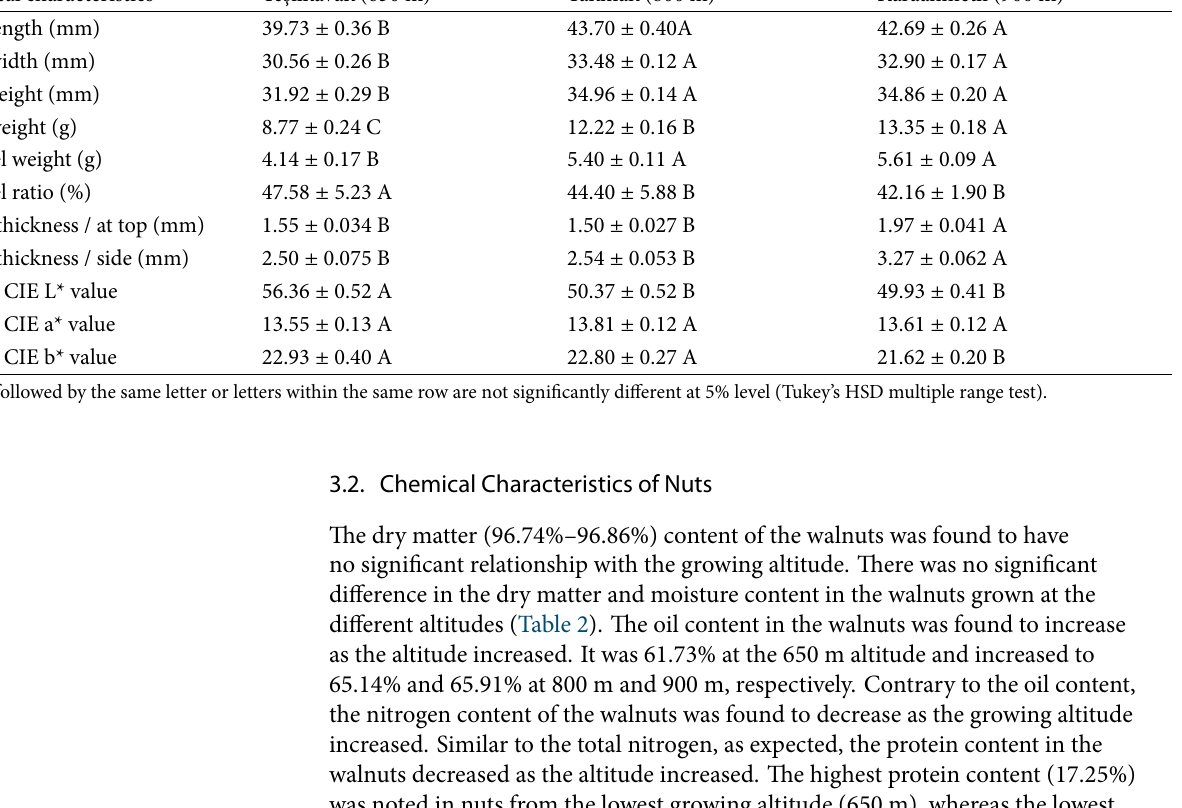
Table 1 Changes in some physical parameters of walnuts ‘Chandler’ according to growing altitude. Physical characteristics